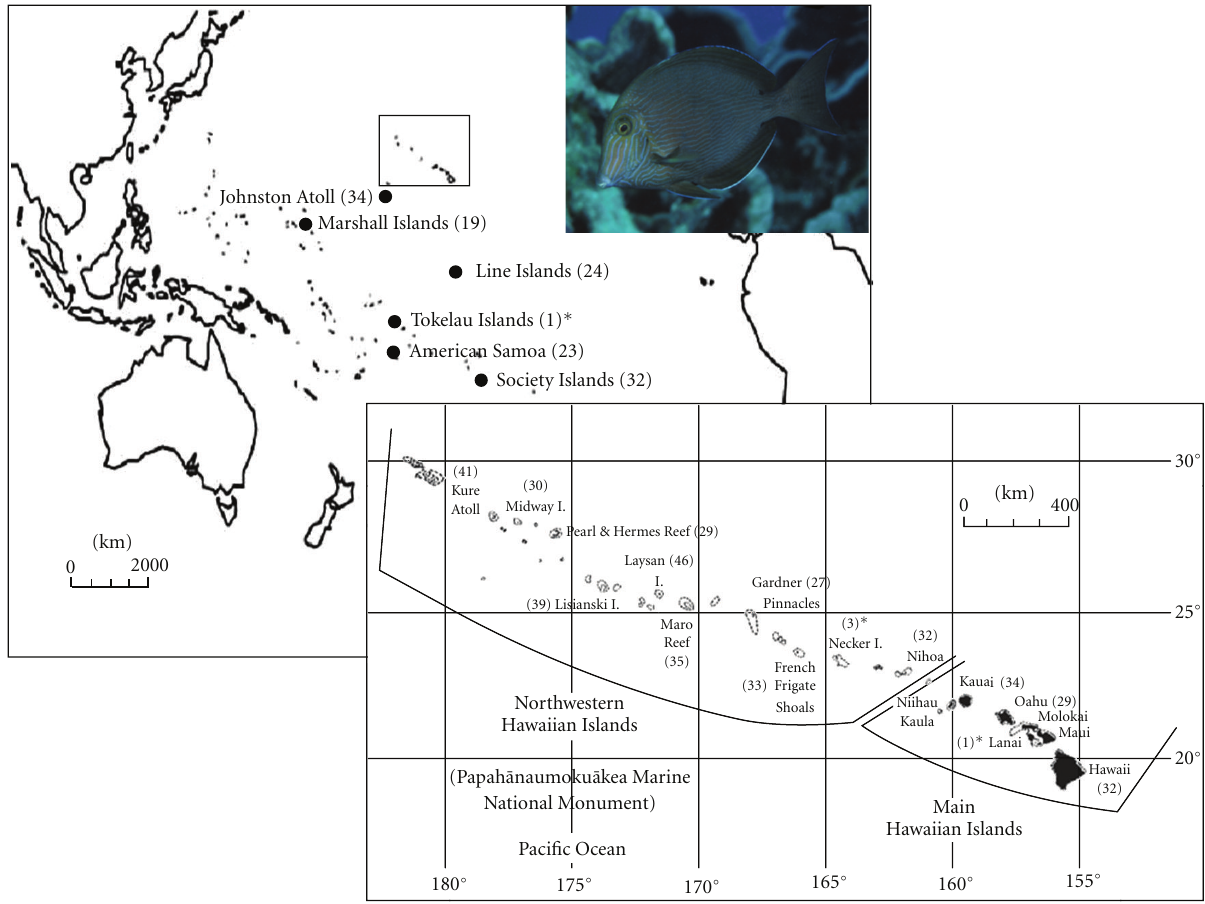
Figure 1: Scaled maps indicating the collection sites and sample sizes for Acanthurus nigroris in the Pacific Ocean. Locations marked with an asterisk were omitted from most population genetic analyses owing to low sample sizes (i.e., N < 6 in all cases) but were included when all (or only “Pacific”) populations were pooled together, as well as in subsequent statistical parsimony networks. Map of the Hawaiian archipelago is courtesy of NOAA. Note that the boundaries of the Papah¯anaumoku¯akea Marine National Monument include only the Northwestern Hawaiian Islands (Photo credit: Jack